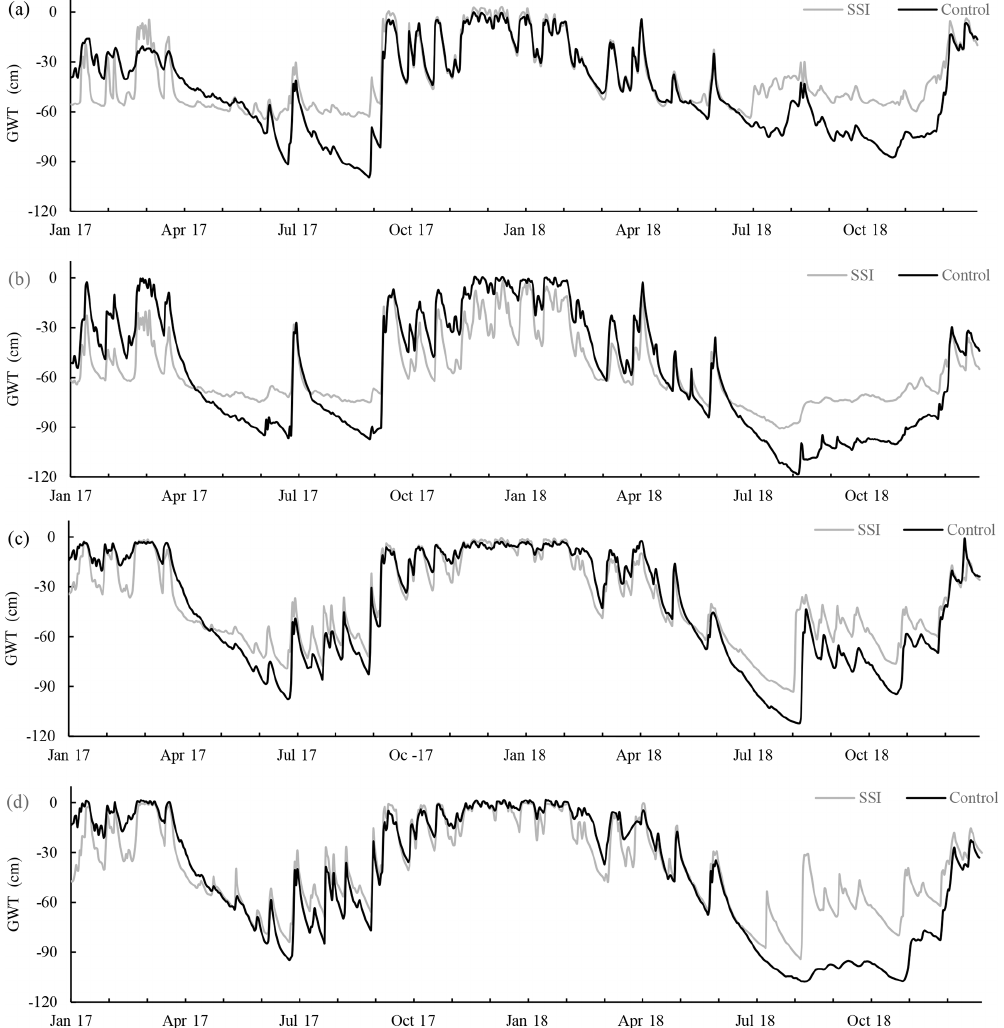
Figure 4. Groundwater table (GWT, from soil surface) during the measuring period per farm (letter); values are shown for SSI (measured at 1.5m from the irrigation pipe) and control treatments.